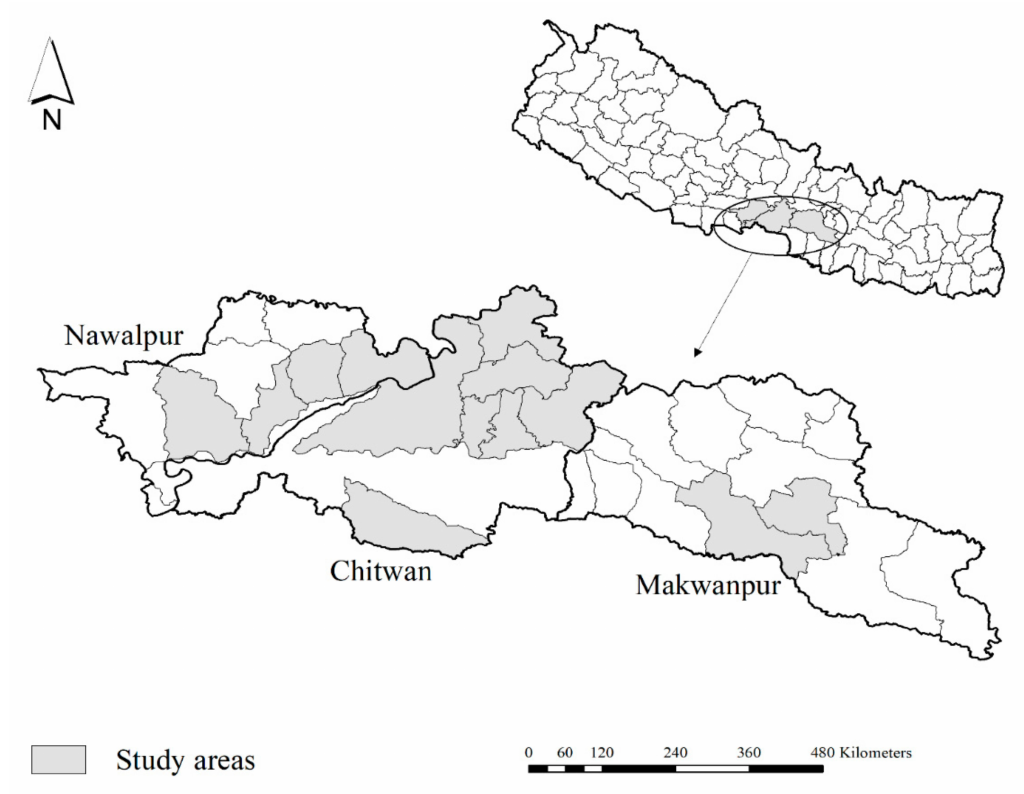
Figure 1. Map of Nepal showing study areas in Chitwan, Nawalpur, and Makwanpur districts. Map was created using ArcGIS version 10.8 (ESRI, West Redlands, CA,